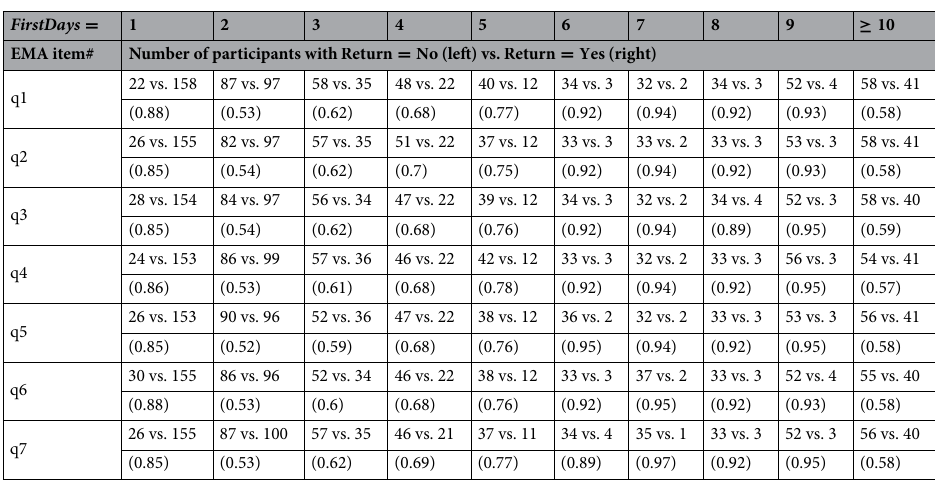
Table 2. For each value of FirstDays , number of participants who did not vs. did return within the horizon of N = 30 days, sorted by EMA item; the likelihood of the majority class for each value of FirstDays and EMA item is shown in